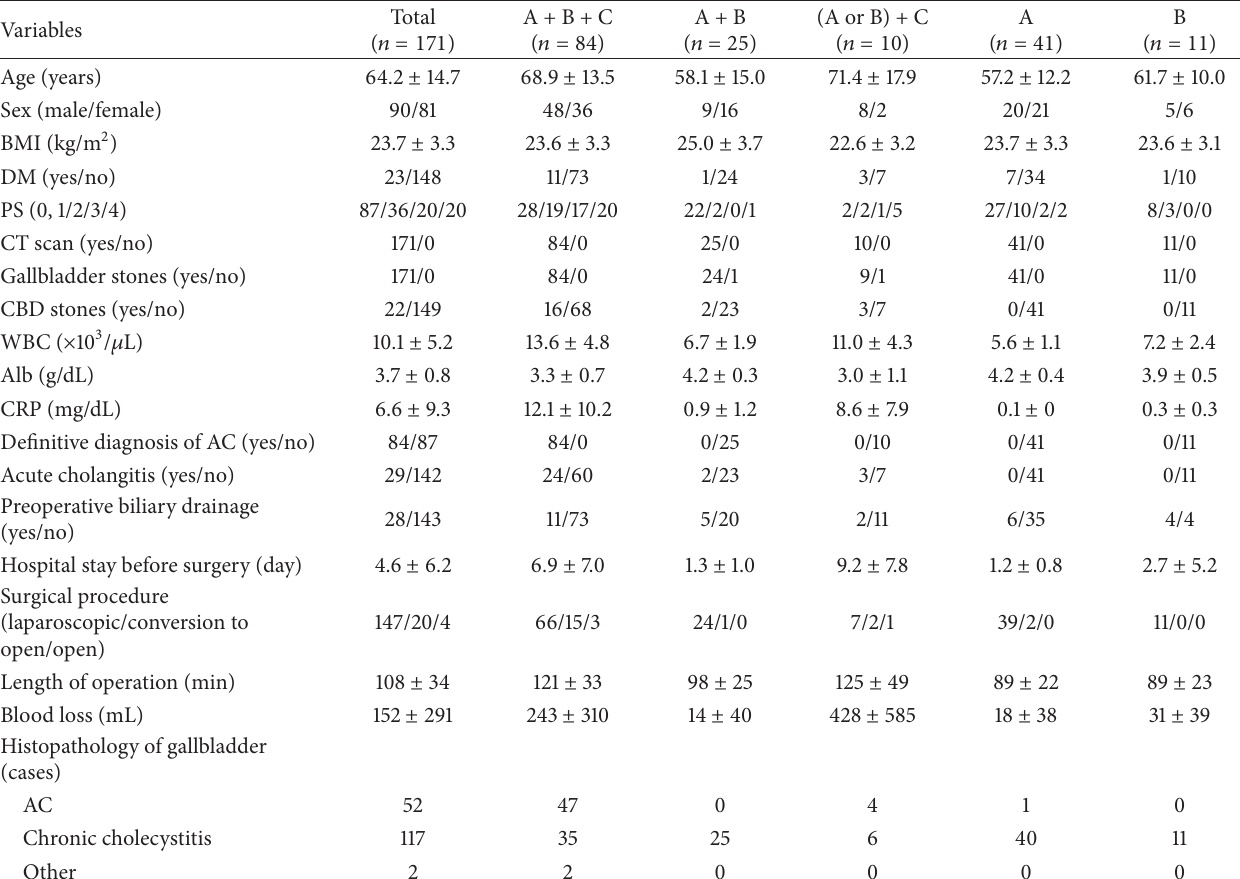
Table 1: Characteristics and medical backgrounds for 171 patients who had definite, suspected, or unmatched AC diagnoses.